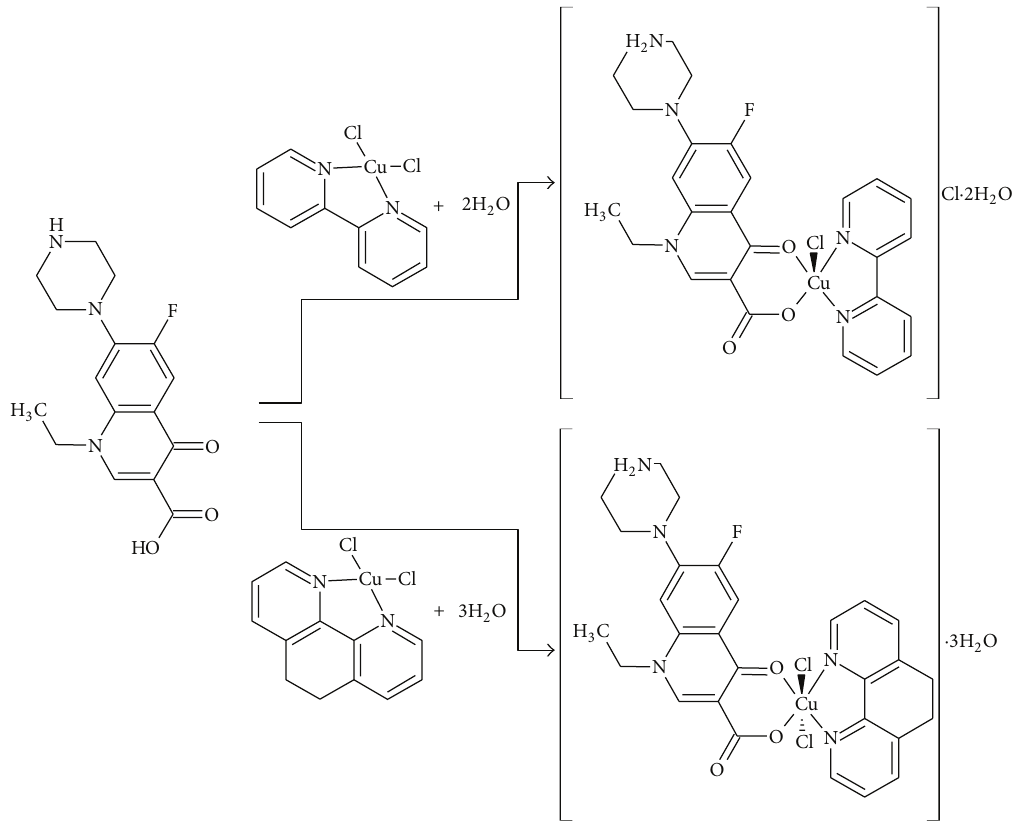
Figure 1: Coordination scheme for complexes 1 and 2